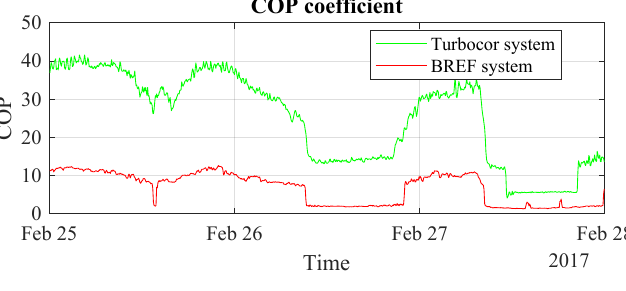
Figure 21. COP on 25–27 February 2017. Table 8. COP profile parameters on 25–27 February